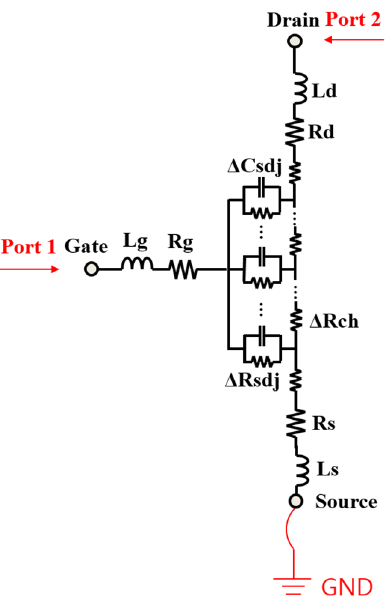
Figure 6. Schematic of GaN HEMT small-signal equivalent circuit in the cold bias region.